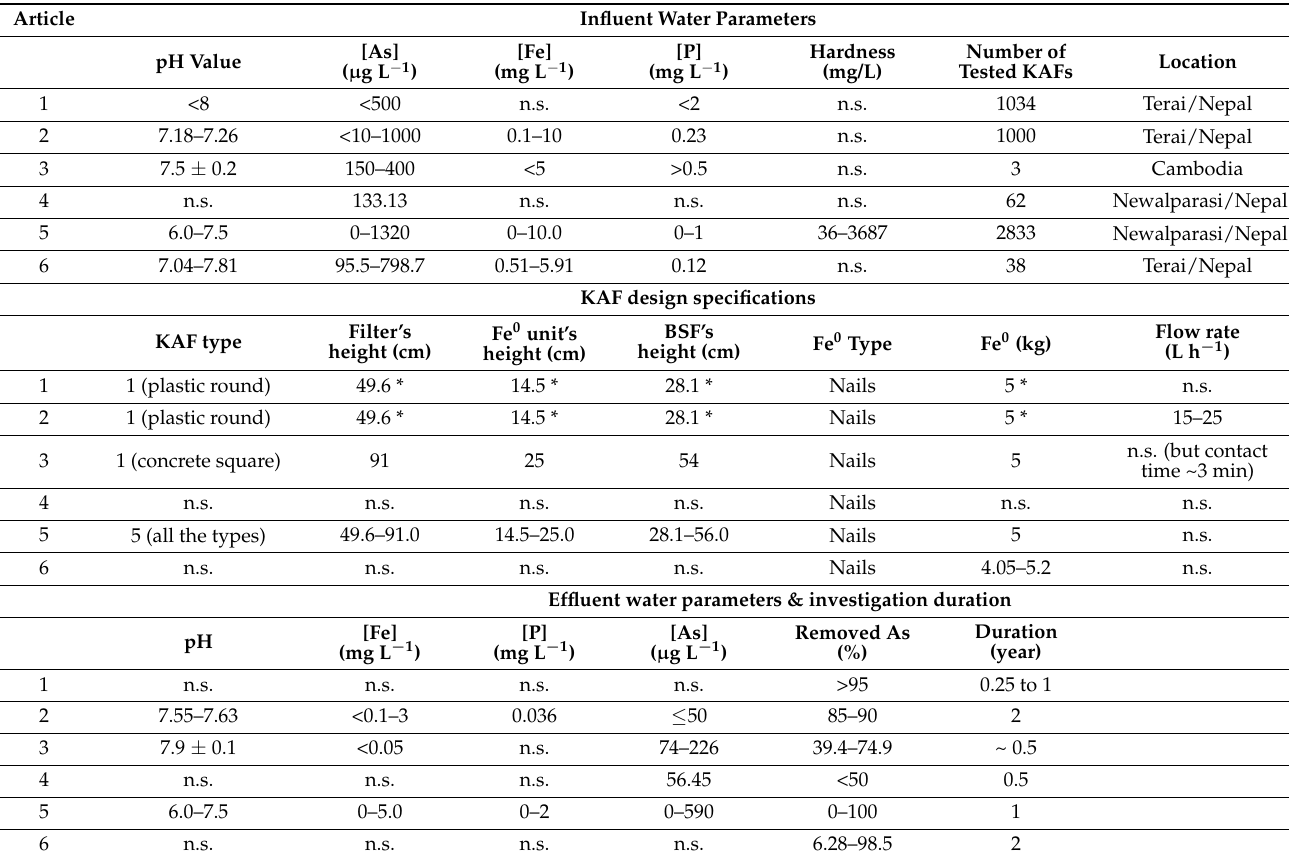
Table 4. Summary of the operational conditions and results from the six KAF assessment studies presented in Table 3. Articles are represented by their numbers as indicated in Table 3. “n.s.” stand for “not